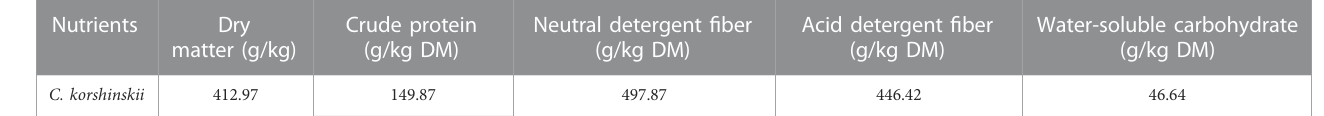
TABLE 1 Chemical composition of pre-ensiling Caragana korshinskii